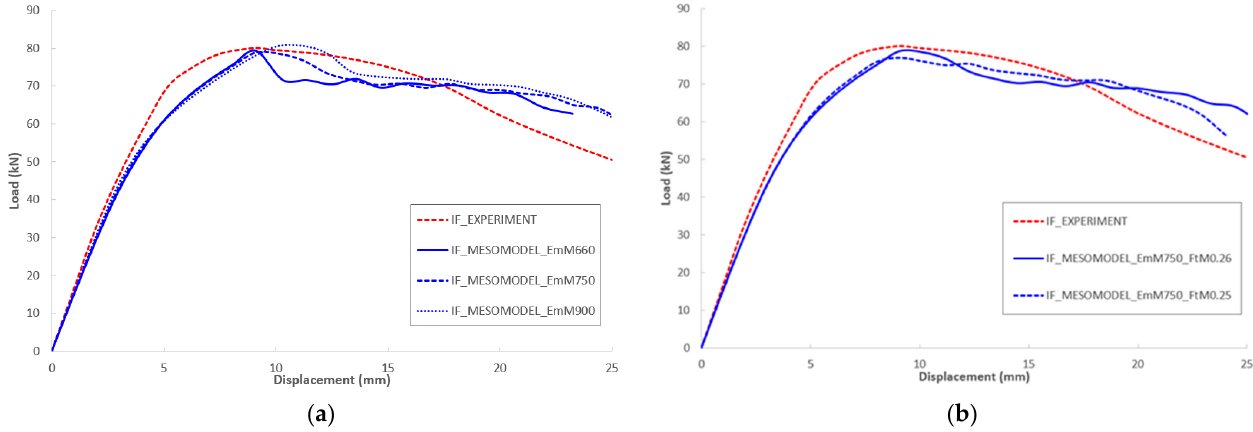
Figure 7. Example of infilled frame sensitivity analysis and validation result: ( a ) IF_meso model with EmM variation; ( b ) IF_meso model with FtM variation.